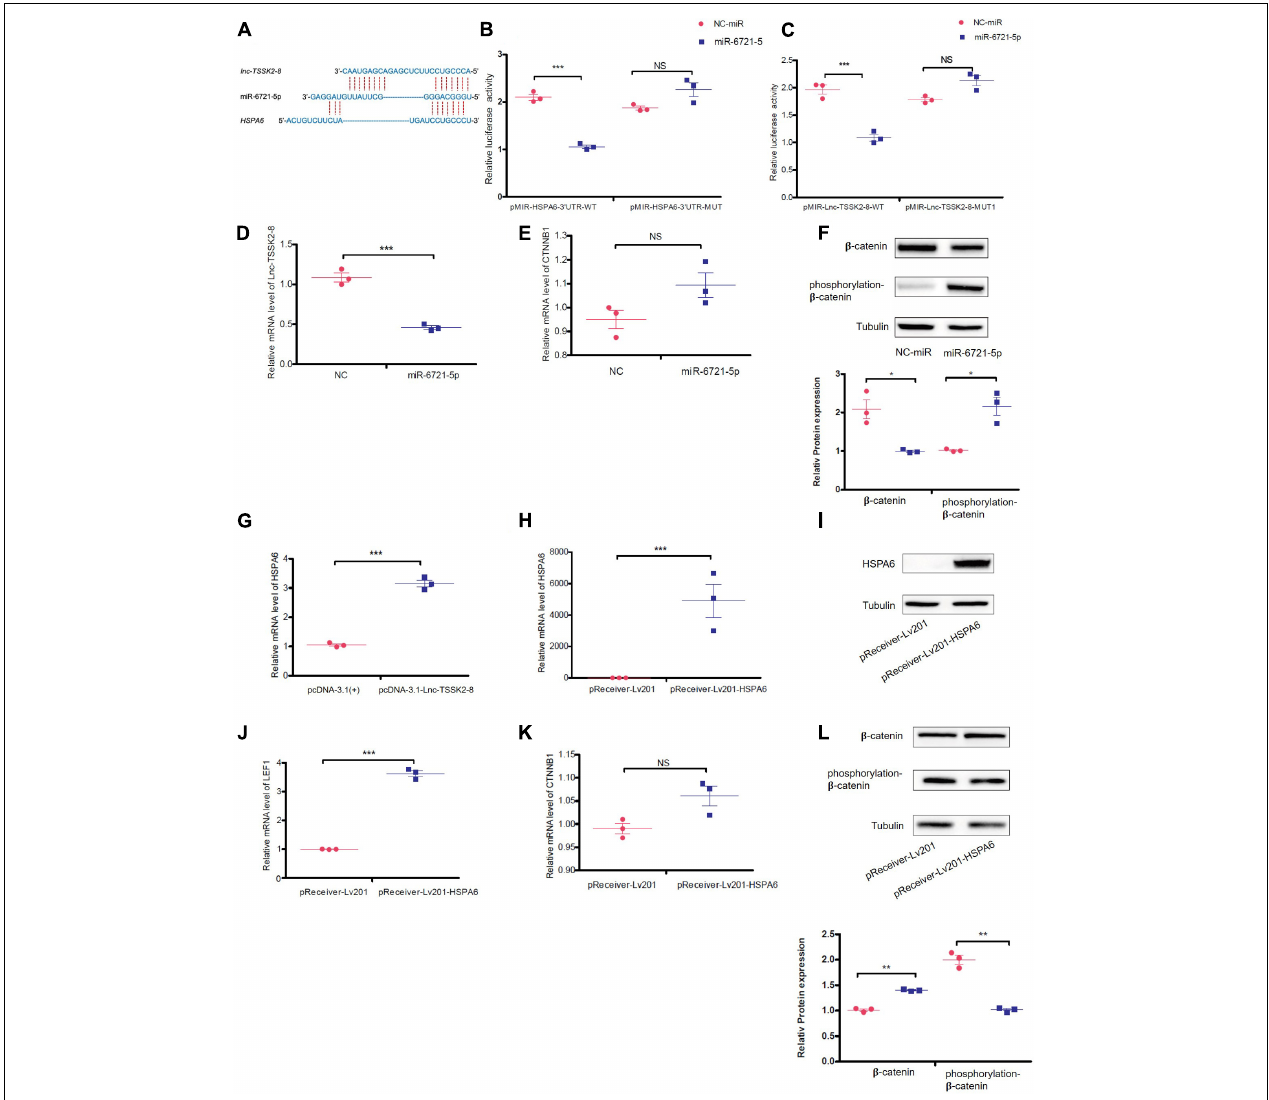
FIGURE 4 | lnc-TSSK2-8 activation promotes β -catenin stabilization through miR-6721-5p/heat shock protein (HSP)A6 axis. (A) The predicted miR-6721-5p binding sites of lnc-TSSK2-8 and HSPA6 3 (cid:48) UTR. (B) The luciferase reporter assay we performed to confirm the interaction between miR-6721-5p and HSPA6 3 (cid:48) UTR (B) / lnc-TSSK2-8 (C) . (D) RT-qPCR analysis of lnc-TSSK2-8 level in response to miR-6721-5p overexpression. (E) RT-qPCR analysis of β -catenin level in response to miR-6721-5p overexpression. (F) Western blot (WB) analysis of protein expression and phosphorylation of β -catenin in response to miR-6721-5p overexpression. (G) RT-qPCR analysis of HSPA6 level in response to lnc-TSSK2-8 overexpression. (H) Confirmation of HSPA6 overexpression with RT-qPCR. (I) Confirmation of HSPA6 overexpression with WB. (J) RT-qPCR analysis of LEF1 level in response to HSPA6 overexpression. (K) RT-qPCR analysis of β -catenin level in response to HSPA6 overexpression. (L) WB analysis of β -catenin protein expression and phosphorylation in response to HSPA6 overexpression. * p < 0.05, ** p < 0.001, ** p <